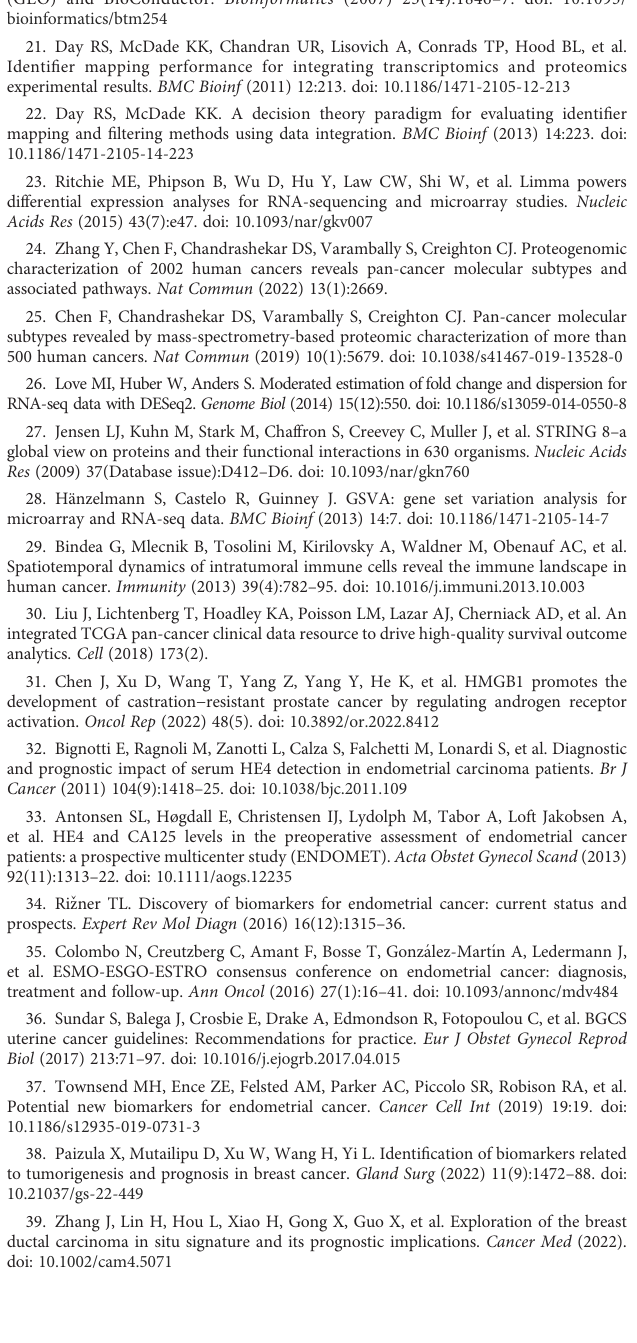
SUPPLEMENTARY FIGURE 1 Differential expression analysis results of KNL1 in pancancer patients. (A) Results of differential analysis of KNL1 expression in 33 tumors based on TCGA database data. (B) Pancancer analysis of paired samples based on data from the TCGA database.